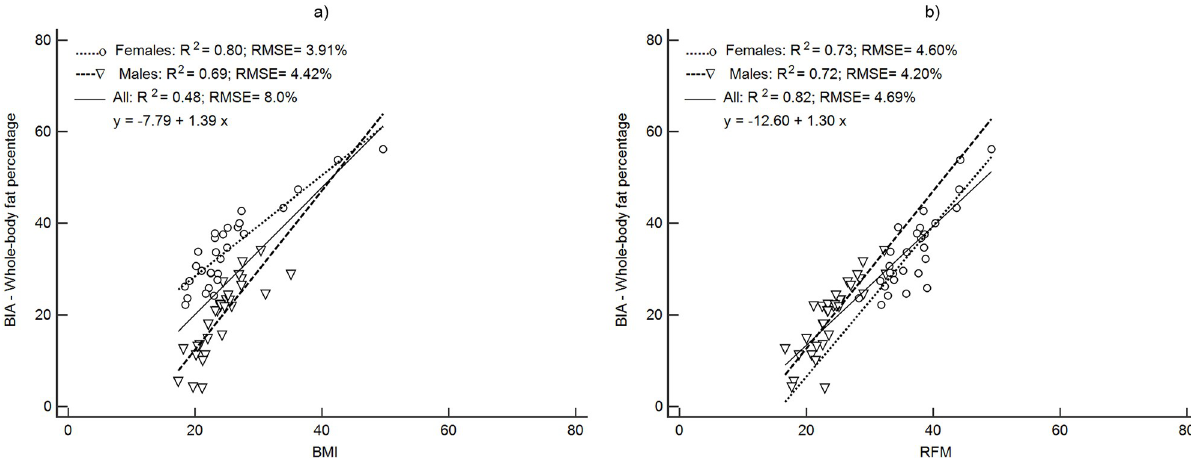
Fig 3. Prediction of FM% from BMI and RFM using BIA as a body composition method. Abbreviations: BIA, bioelectrical impedance analysis, body mass index; RFM, relative fat mass; RMSE, root mean squared